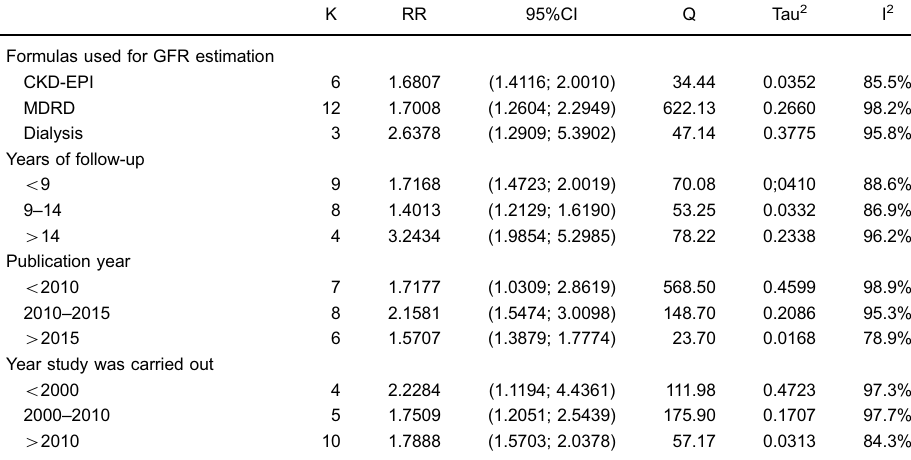
Table 3. Meta-regression results for subgroups (random effects